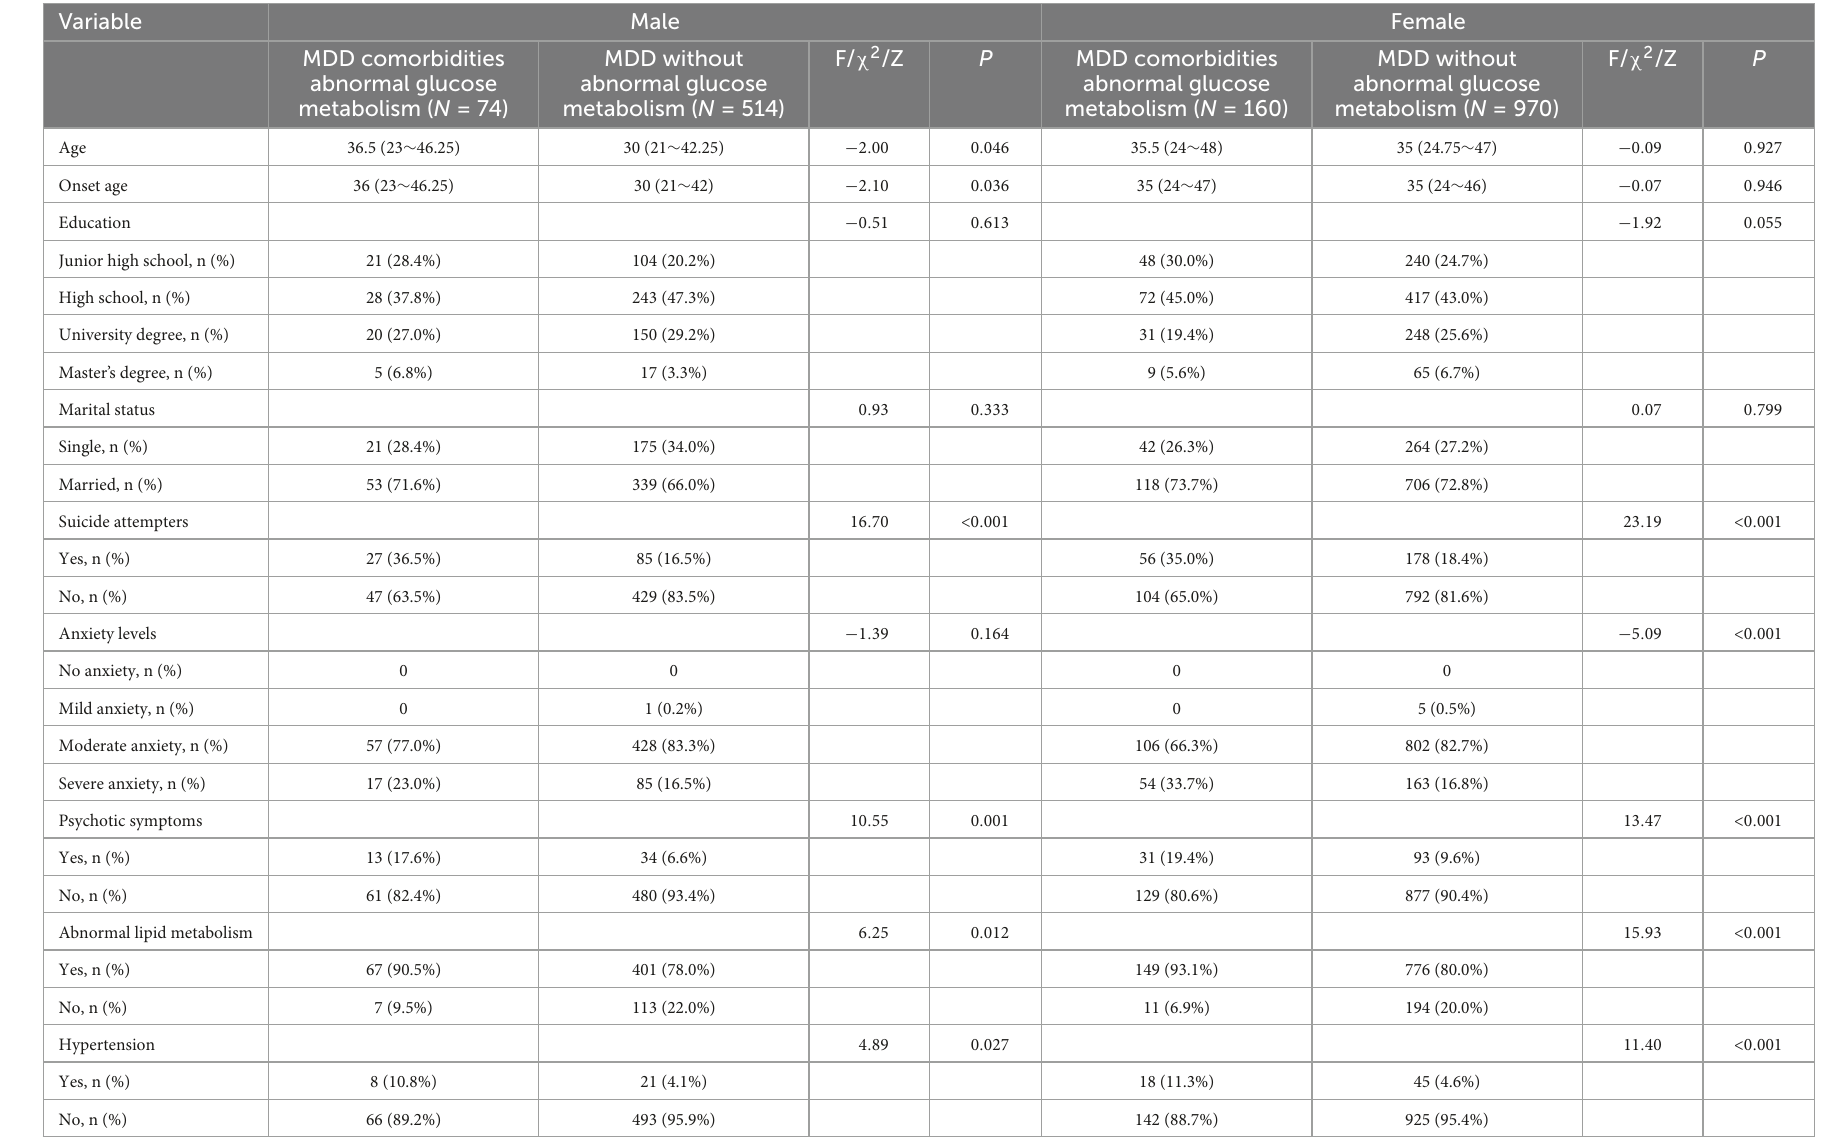
TABLE 1 Sociodemographic and clinical characteristics of male and female MDD patients with and without abnormal glucose metabolism.